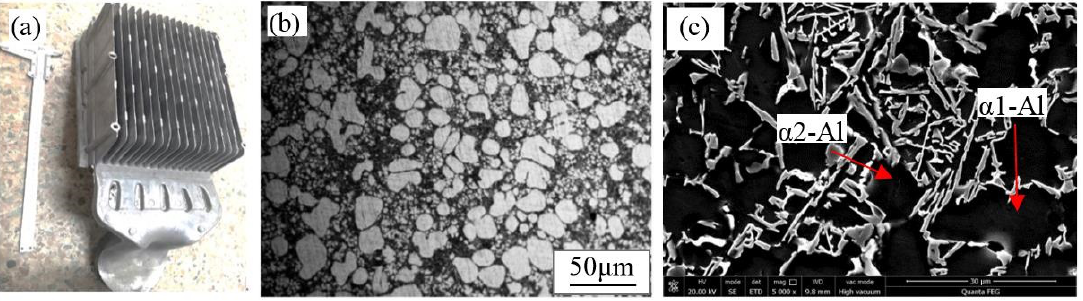
Figure 9. The microstructure of Al-Si alloy communication parts by planetary stirring semi-solid technology. ( a ) Communication cooling shell part, ( b ) Metallographic diagram, ( c ) SEM diagram.